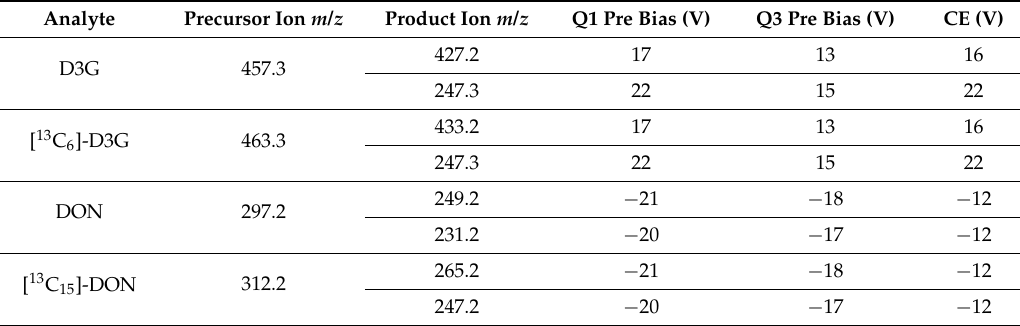
Table 1. LC-MS/MS parameter of the stable isotope dilution assay of D3G and DON.